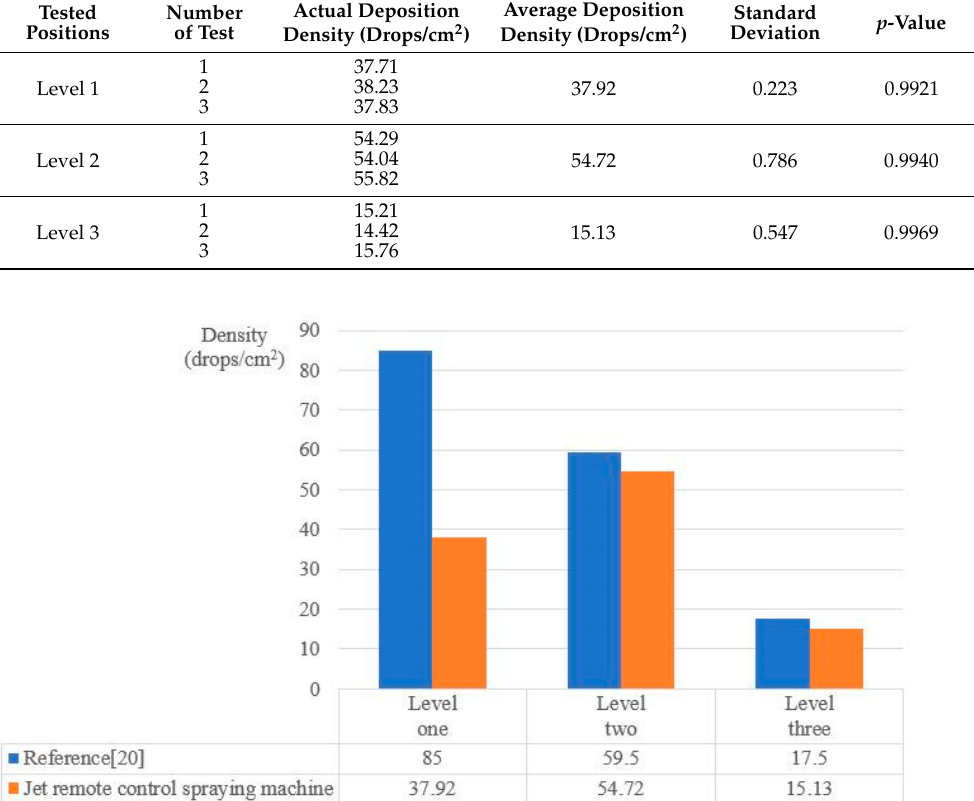
Figure 12. Comparison chart of droplet deposition density.